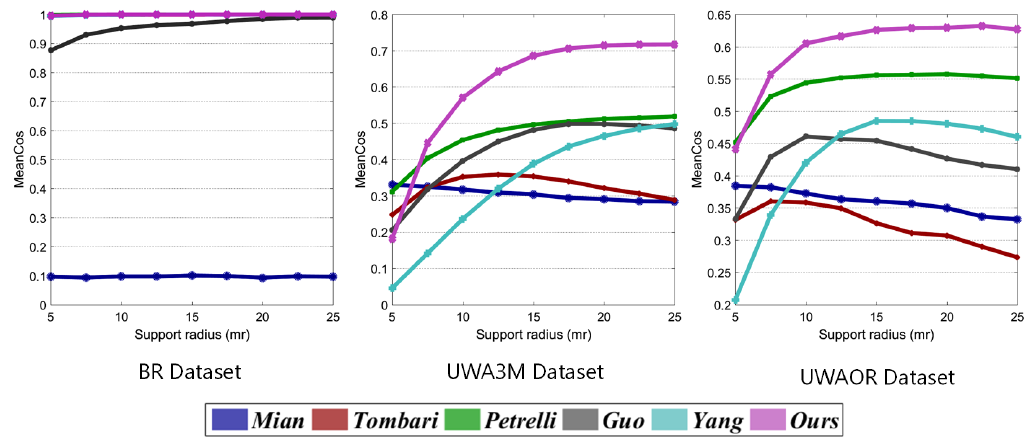
Figure 12. MeanCos performance of six LRF methods under varying support radius on three public dataset.